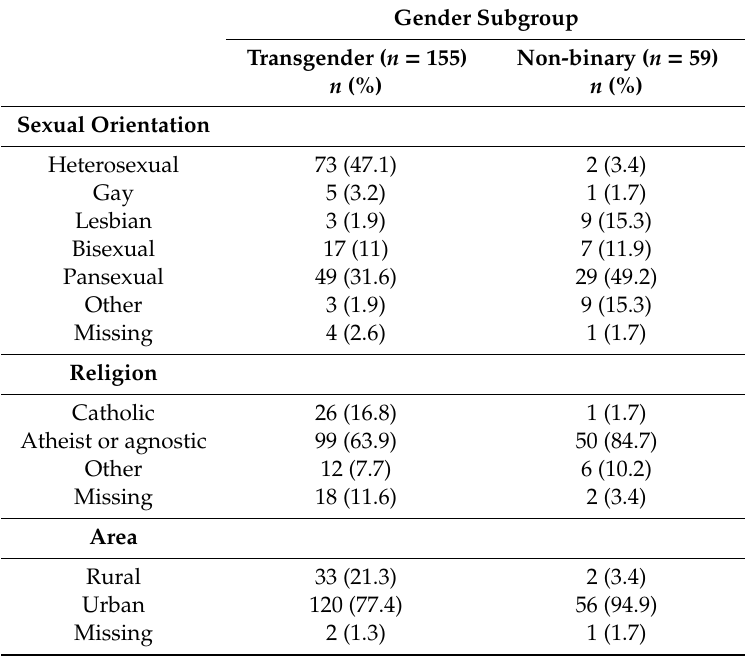
Table 1. Demographic